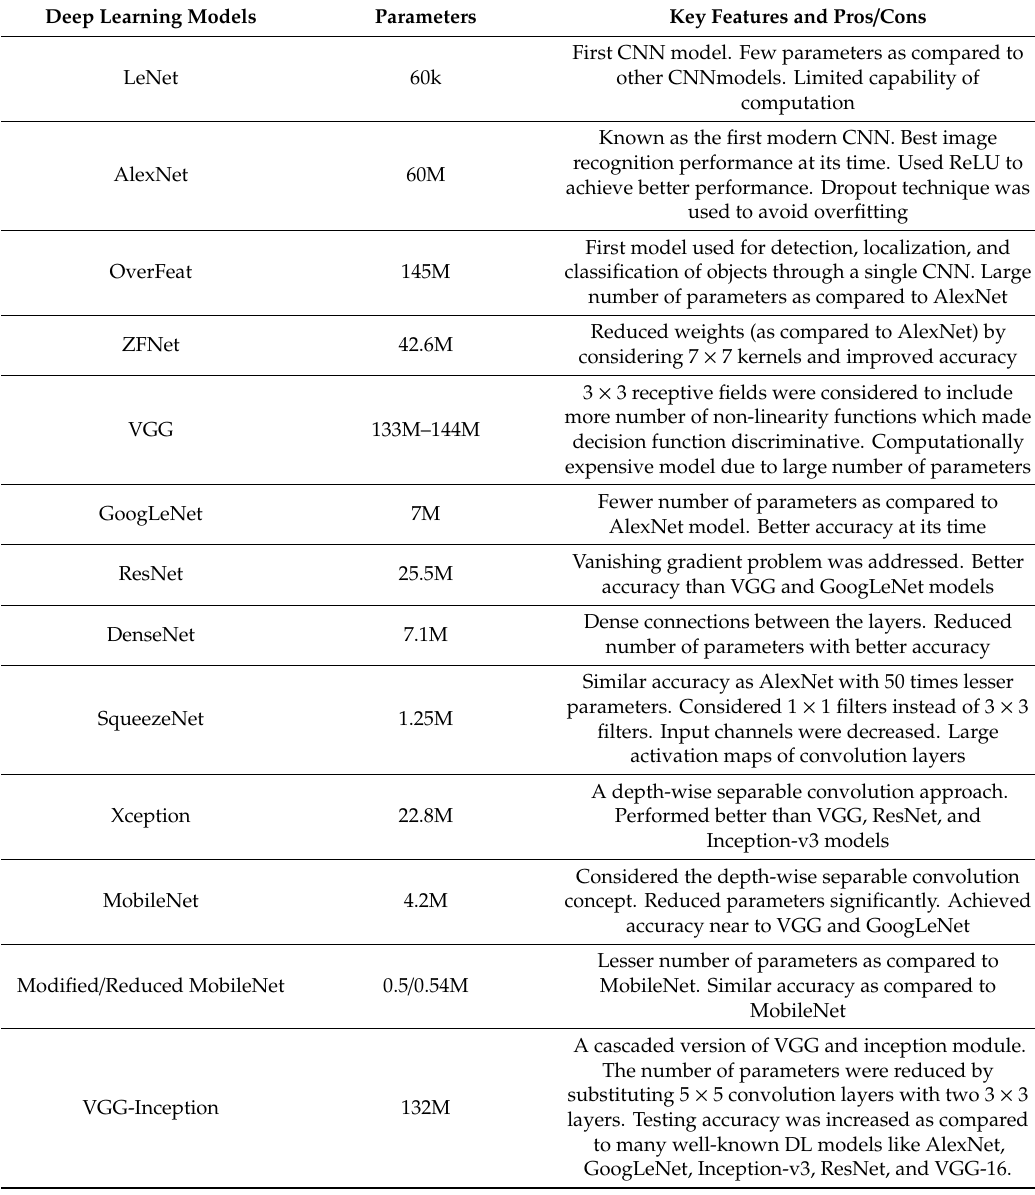
Table 1. Comparison of state-of-the-art deep learning